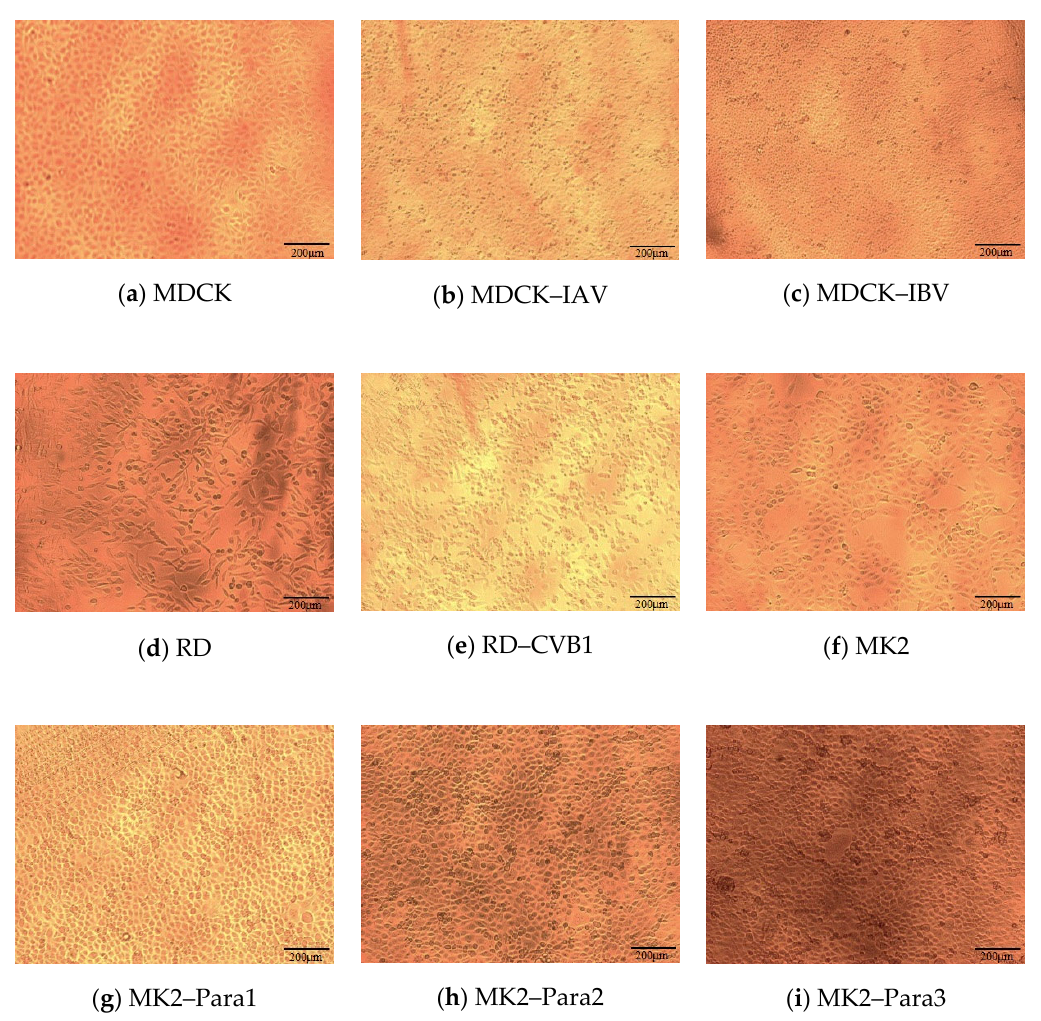
Figure 1. Types of images used in the dataset. ( a ) Original MDCK cell, ( b ) MDCK cell infected by IAV, ( c ) MDCK cell infected by IBV, ( d ) original RD cell, ( e ) RD cell infected by CVB1, ( f ) original MK2 cell, ( g ) MK2 cell infected by Para1, ( h ) MK2 cell infected by Para2, and ( i ) MK2 cell infected by Para3.